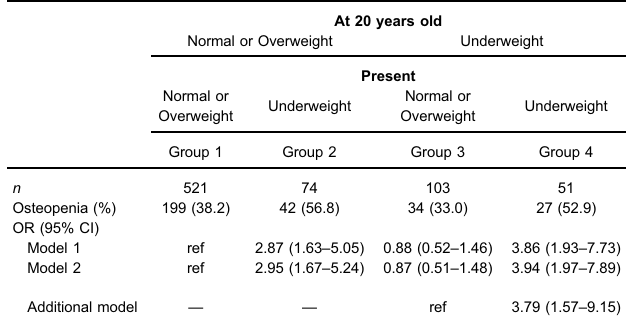
Additional model — ref